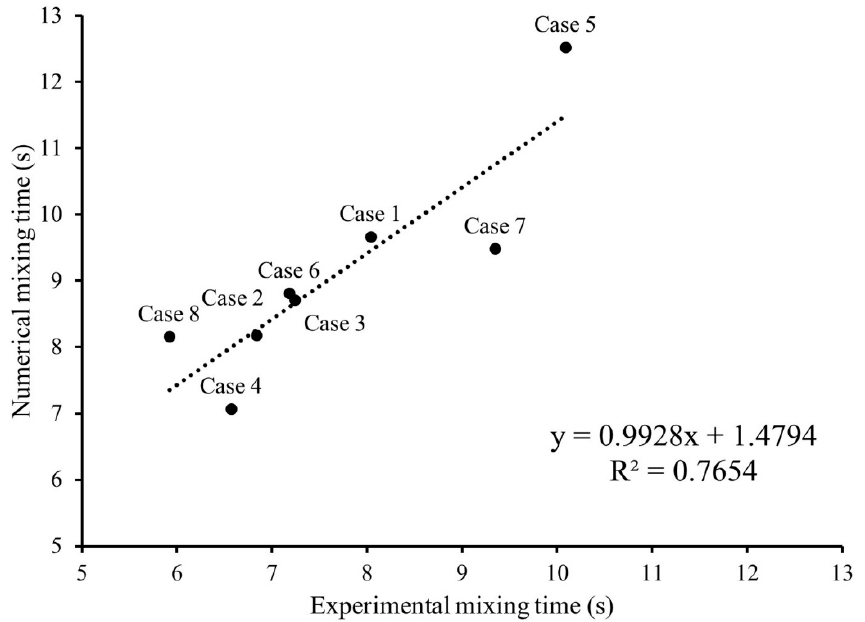
Figure 9. Comparison between the model prediction (dotted line) and experimental mixing time (black dots) obtained by Jardón-Pérez et al. [15].